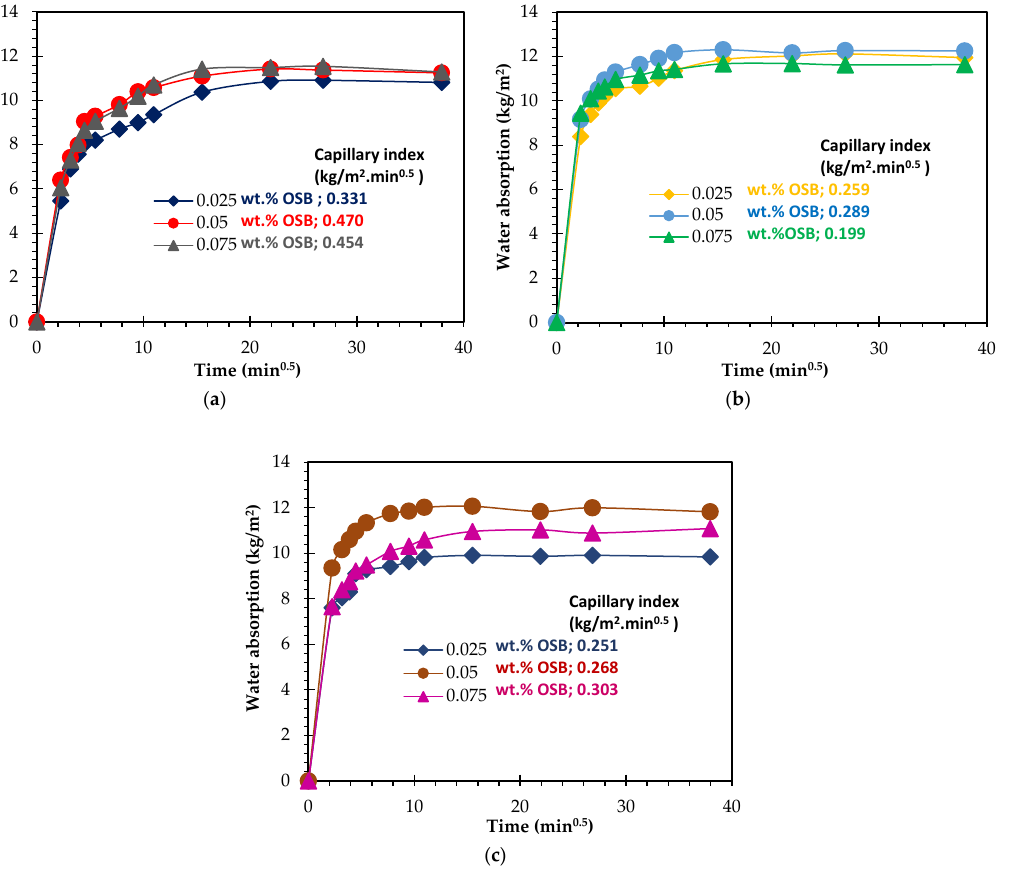
Figure 7. Capillary water absorption and index of GFs prepared with different content (0.025, 0.05, and 0.075 wt.%) of Hostapur OSB and ( a ) 0.05 wt.% Al, ( b ) 0.075 wt.% Al, and ( c ) 0.1 wt.% Al.